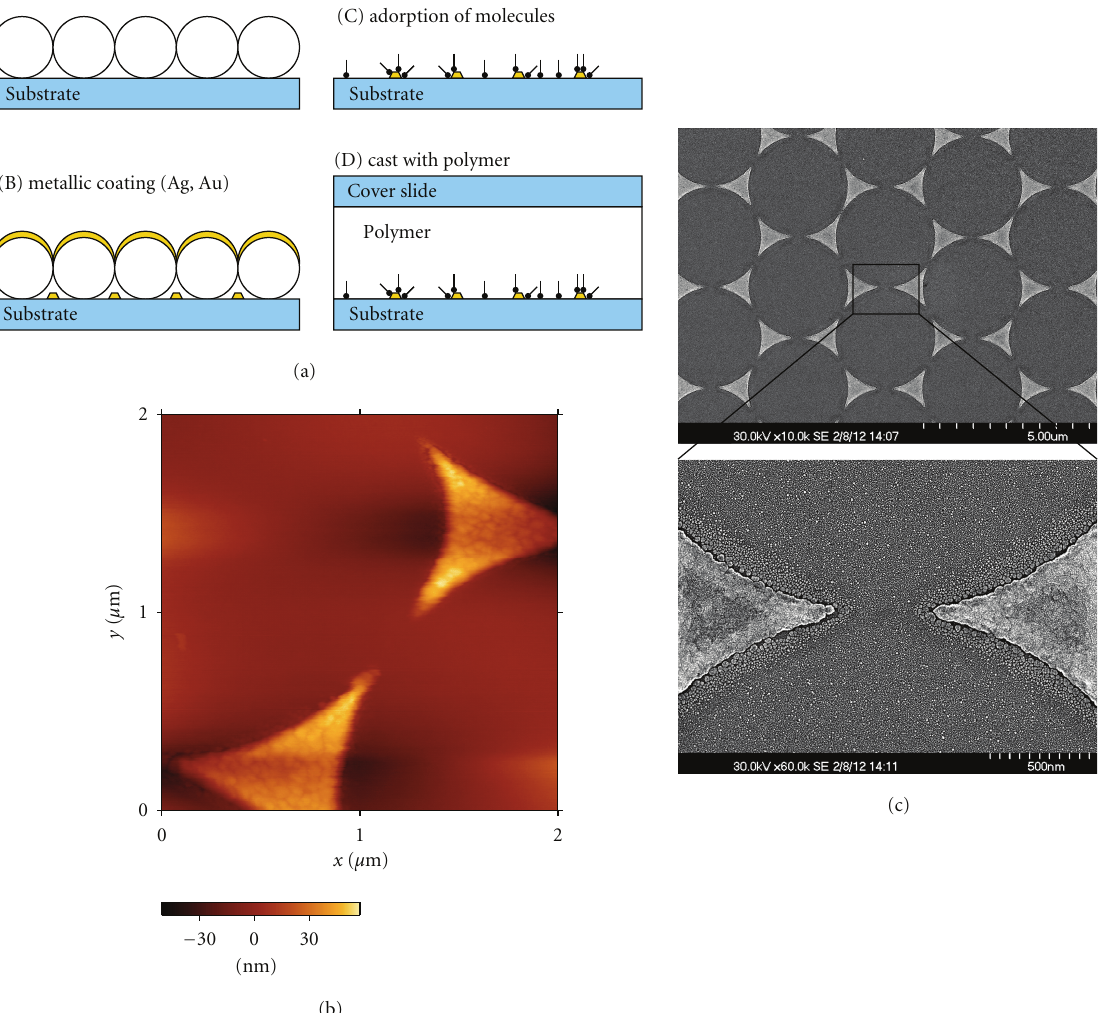
Figure 1: (a) Fabrication steps of metal templates by nanosphere lithography. (A) Colloidal crystals formed by crystallization of PS spheres during solvent evaporation. (B) Metal coating. (C) Molecules in solution adsorbed (physisorbed or chemisorbed) at the metal nanoparticles obtained after spheres lift-o ff . (D) Polymer cast used to protect the sample and to change refractive index of the medium close to the metal nanoparticles. Using transparent substrates, the illumination of the sample can be done from both sides. (b) AFM topography image of a Ag pattern with 50 nm film thickness. (c) SEM micrographs of a 50nm thick silver pattern, fabricated using PS spheres of 3 diameter. Small clusters (30 to 50nm) are found close to the triangular particles. The smaller clusters between the triangles are formed by sputtering of a gold-palladium target, used for the coating required for the scanning electron microscope. This coating has a thickness of 4 nm.